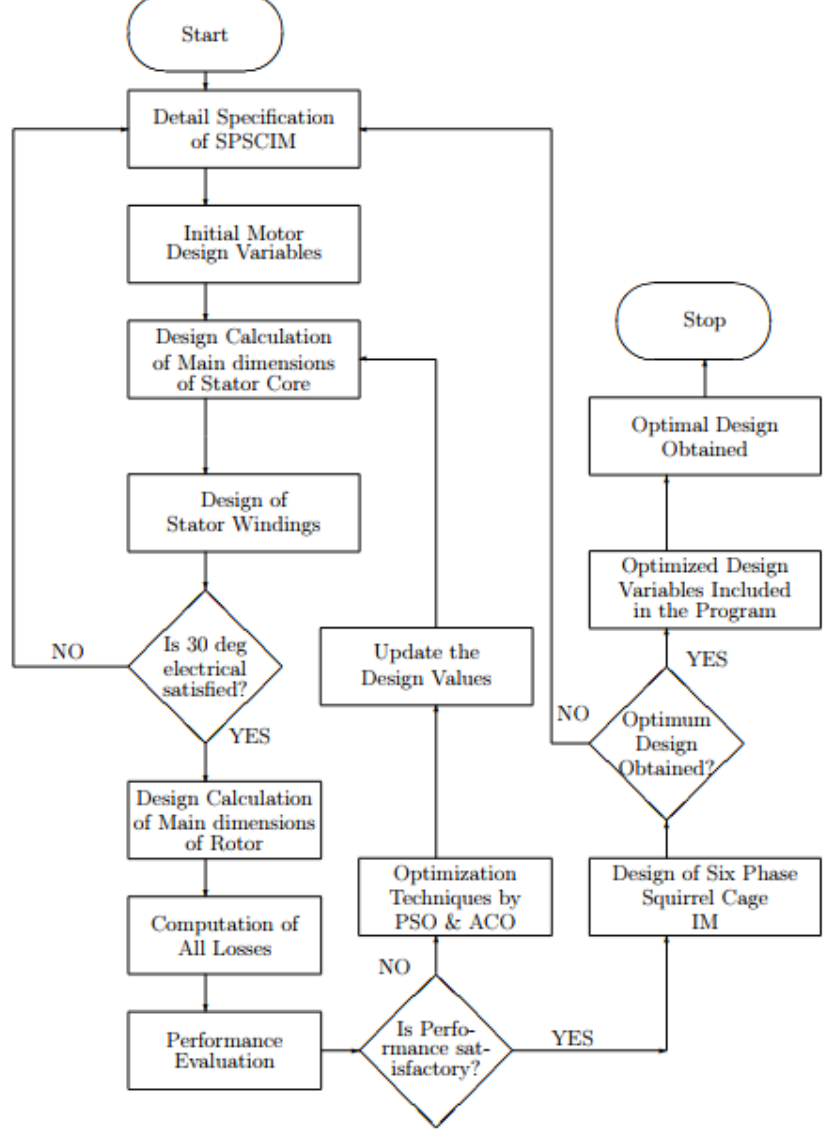
Figure 1. Overall Flowchart of the System